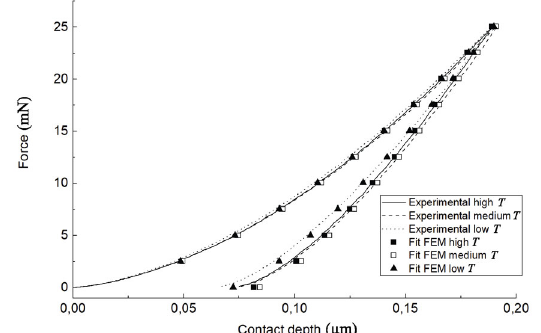
Fig. 14 Comparison of the modulus measured normal to the coating surface at coatings with different deposition temperature using Oliver & Pharr method and the inverse